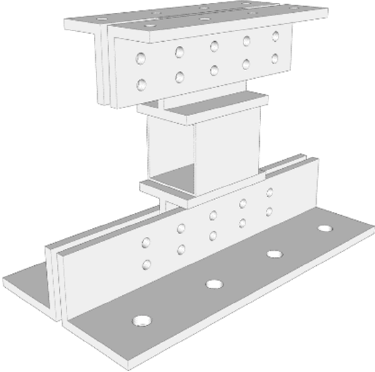
Figure 1. Schematic diagram of shear square section steel tube damper.